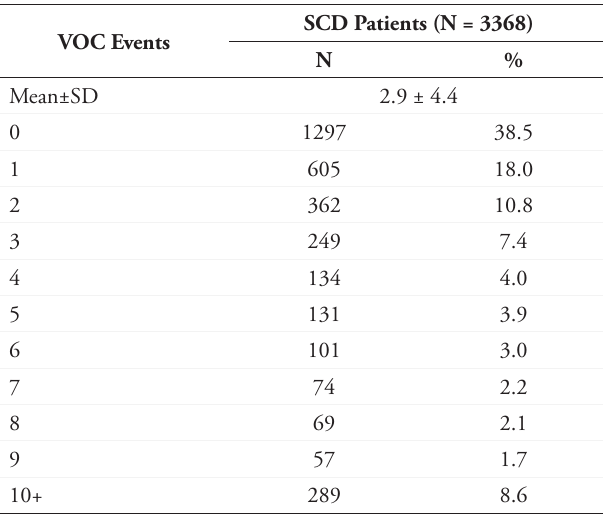
SCD Patients (N = 3368) N